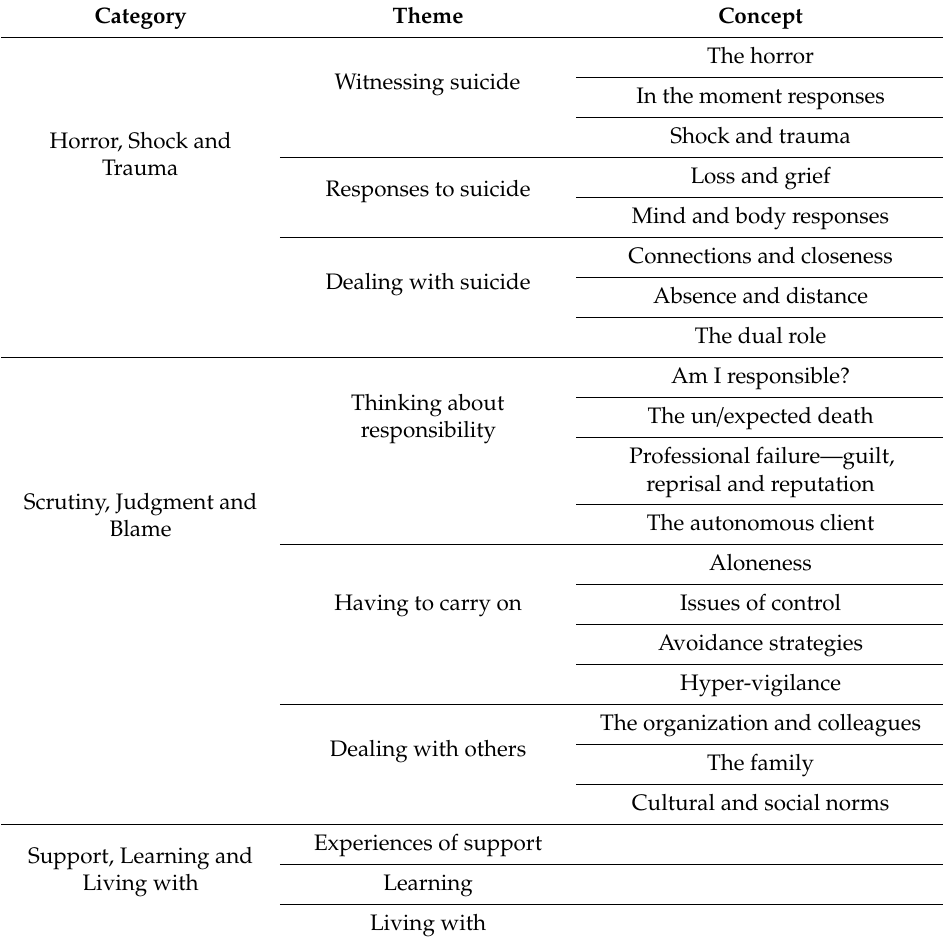
Table 2. Categories, themes and